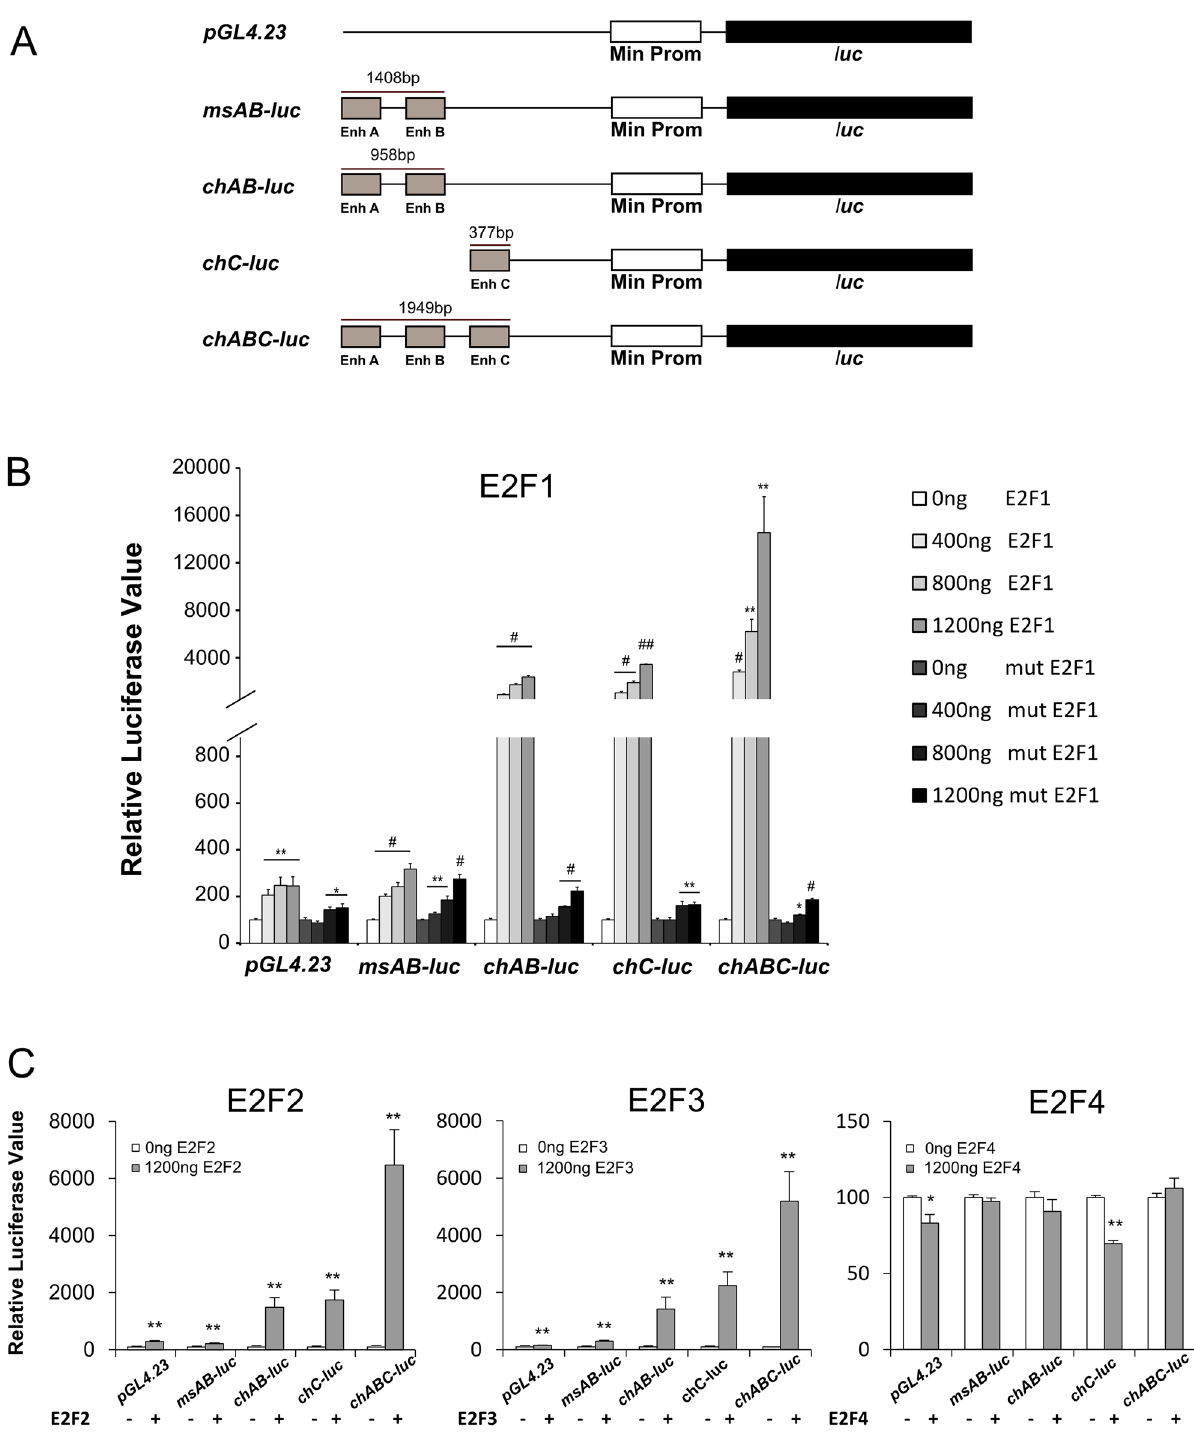
Figure 2. Effect of the E2F transcription factors on the mouse and chick Atoh1 enhancers and putative enhancer C. ( A ) Schematic representation of the luciferase constructs containing the mouse or chick Atoh1 conserved regions cloned into the luciferase vector pGL4.23 . ( B ) Dose–response effects on the Atoh1 luciferase constructs of transfecting increasing amounts of an E2F1 expression construct or mutant E2F1 in the UB/OC-2 cell line. ( C ) Effect of E2F2, E2F3 and E2F4 on the activity of the Atoh1 luciferase constructs. Experiments were conducted in triplicate in two separate assays with different DNA preparations for each plasmid in each assay (n = 6). Relative luciferase values are expressed relative to activity of the reporters in the absence of E2F. Student t -test was conducted comparing each condition with 0 ng of the corresponding E2F expression construct. (* p < 0.05; ** p < 0.01; # p < 10 –5 ; ## p < 10 –10 ). Error bars represent the s.e.m (n =